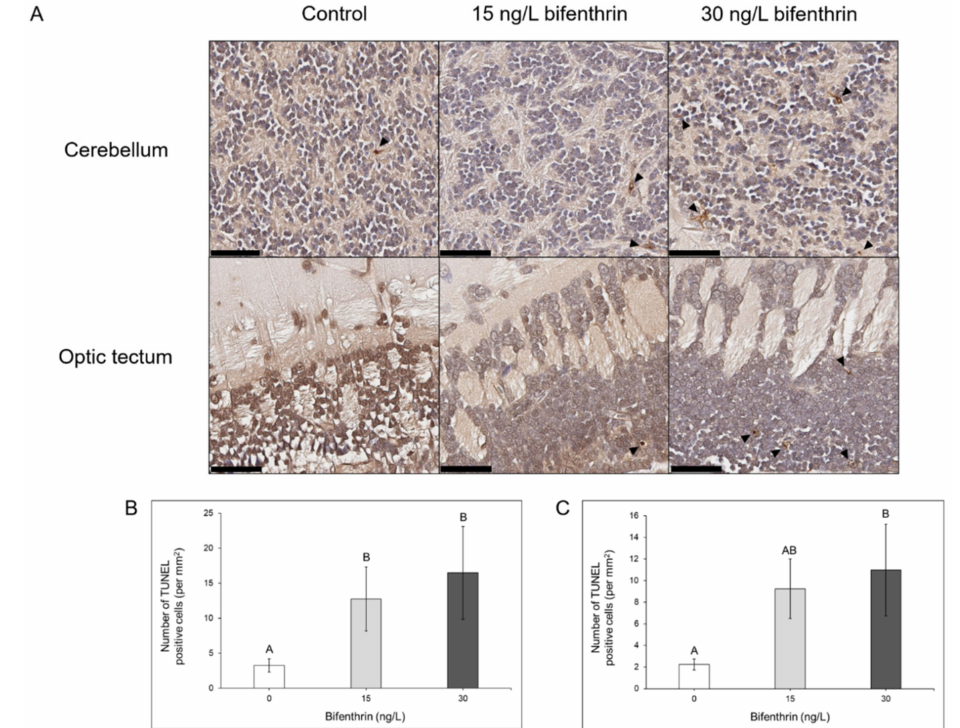
Figure 3. TUNEL positive cells assessed in the ( A , B ) cerebellum and ( A , C ) optic tectum of juvenile rainbow trout exposed to 0, 15, and 30 ng/L bifenthrin. TUNEL positive cells were quantified by the number of brown-stained nuclei per 1 mm 2 , denoted by dark arrows, and black bars represent a 50 µ M scale bar ( A ). Treatments with different uppercase letters are representative of statistically significant treatments from other treatment groups ( p <